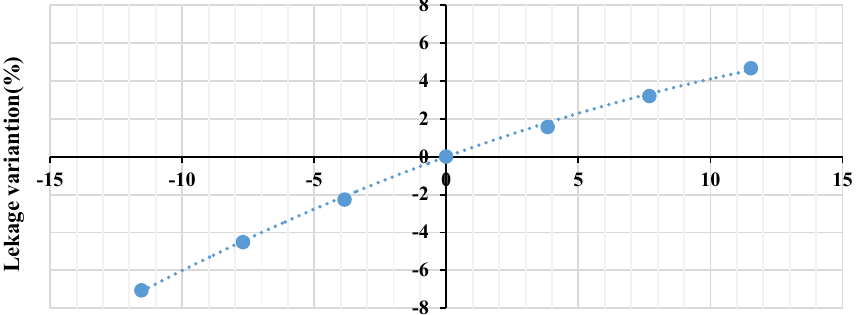
Fig. 7 Variation in network leakage versus Hazen–Williams coefficient for two-loop WDN